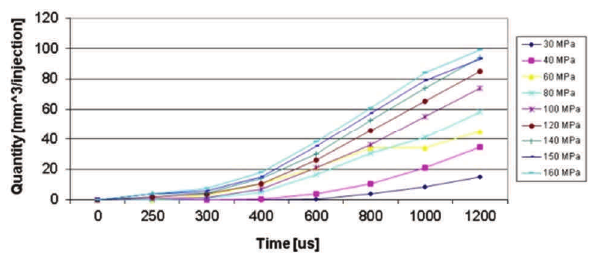
Fig. 13. Characteristic with pump speed 1100 rpm